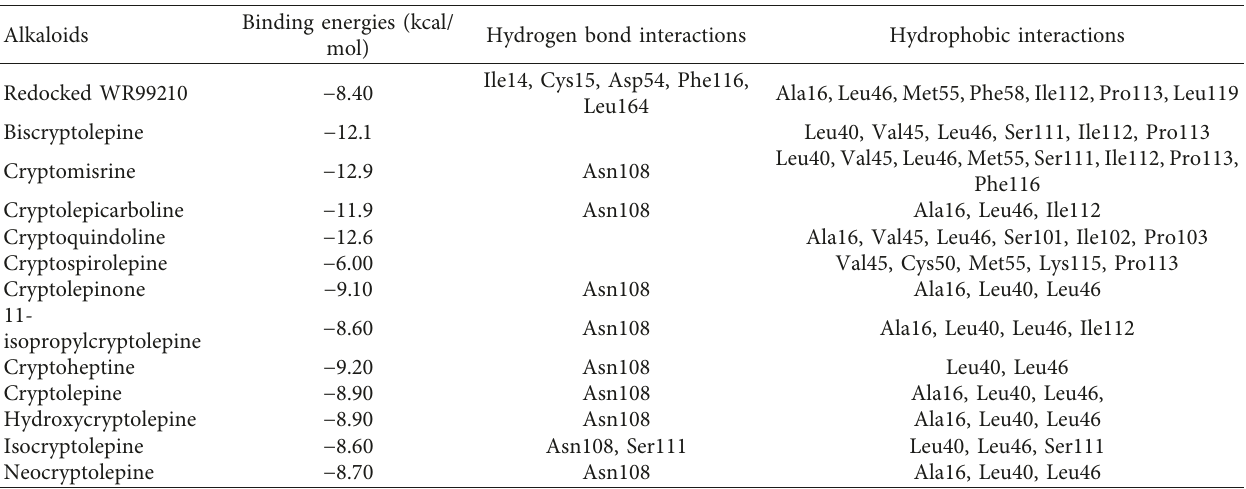
Table 4: Molecular docking result of WR99210 and Cryptolepis sanguinolenta alkaloids with quadruple mutant Pf DHFR (1J3K). Binding energies (kcal/ Alkaloids